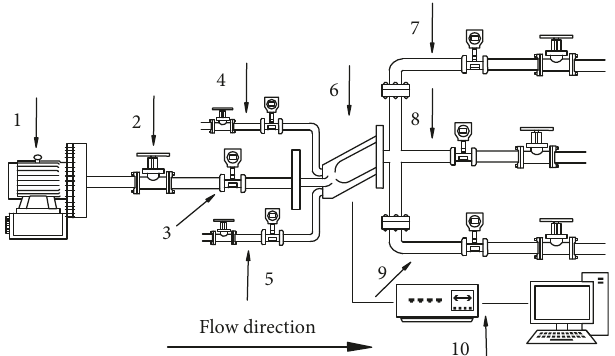
Figure 5: Test system schemes: (1) compressor, (2) main valve, (3) vortex street fl owmeter, (4) rotameter of outer annulus fl ow path, (5) rotameter of inner annulus fl ow path, (6) dump di ff user, (7) outer annulus fl ow path fl ow control, (8) fl ame tube fl ow control, (9) the inner fl ow control, and (10) data acquisition system.